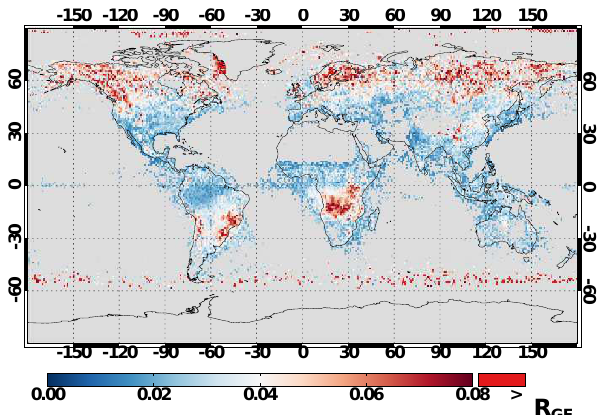
water vapour patterns tied to the Indian and East Asia mon-